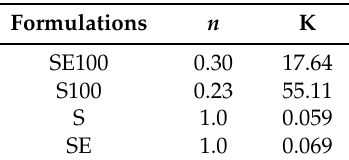
Table 2. Flow behavior ( n ) and consistency index (K) of the formulations. Formulations